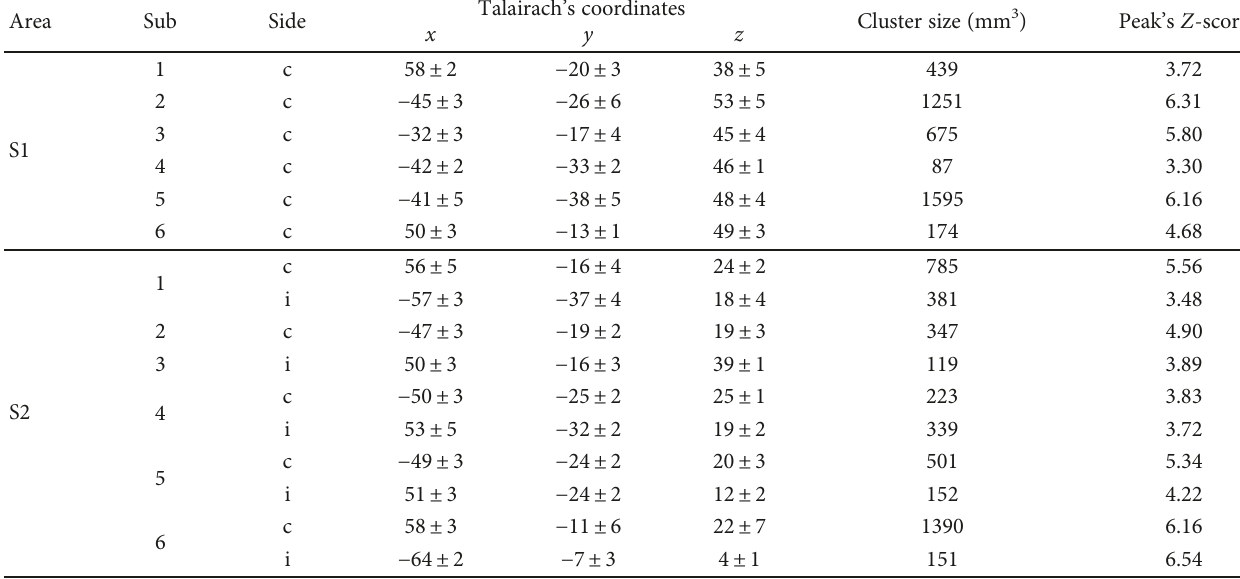
Table 2: Centre of mass localization, extension, and peak Z -score ( Z ∗ ) for primary (S1) and secondary (S2) somatosensory areas, identi fi ed by the gentle tactile stimulation of the paretic hand for each single